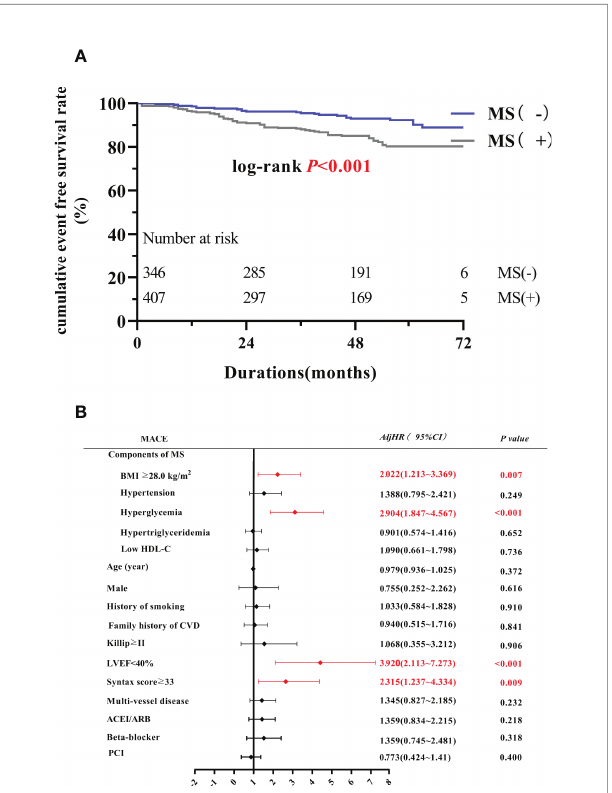
FIGURE 2 | MS and PMI prognosis. (A) The Kaplan-Meier curve between MS group and non-MS group. (B) Multivariate Cox regression analysis of MACE. MACE, major adverse cardiovascular events; LVEF, left ventricular ejection fraction; ACEI/ARB, angiotensin converting enzyme inhibitor/angiotensin II receptor blocker; AdjHR, adjusted hazard ratio; CI, con fi dence interval; PCI, percutaneous coronary